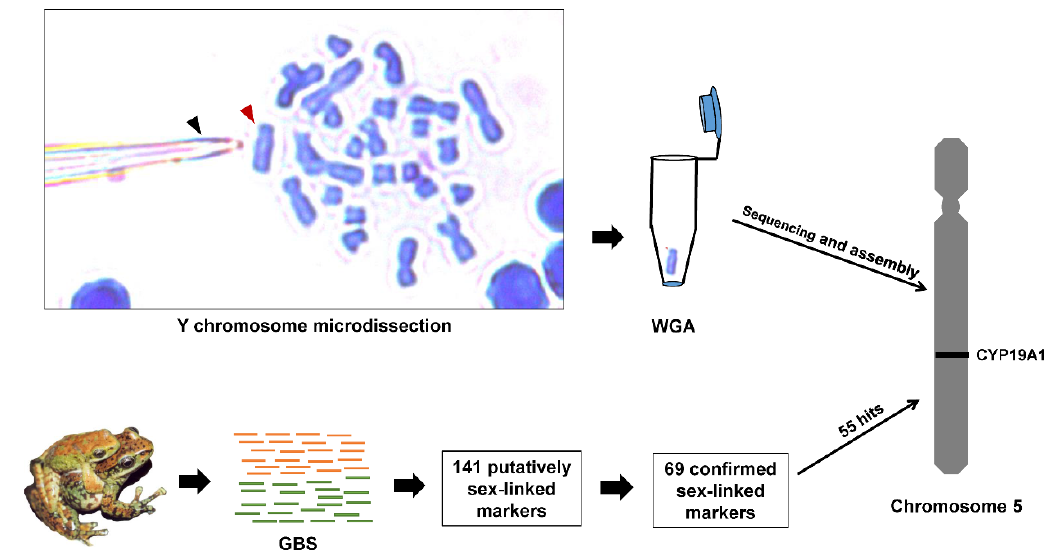
Figure1. Summaryofapproachesforassigningsex-linkedmarkerstotheYchromosomeof A.mantzorum Figure 1. Summary of approaches for assigning sex-linked markers to the Y chromosome of A. mantzorum.